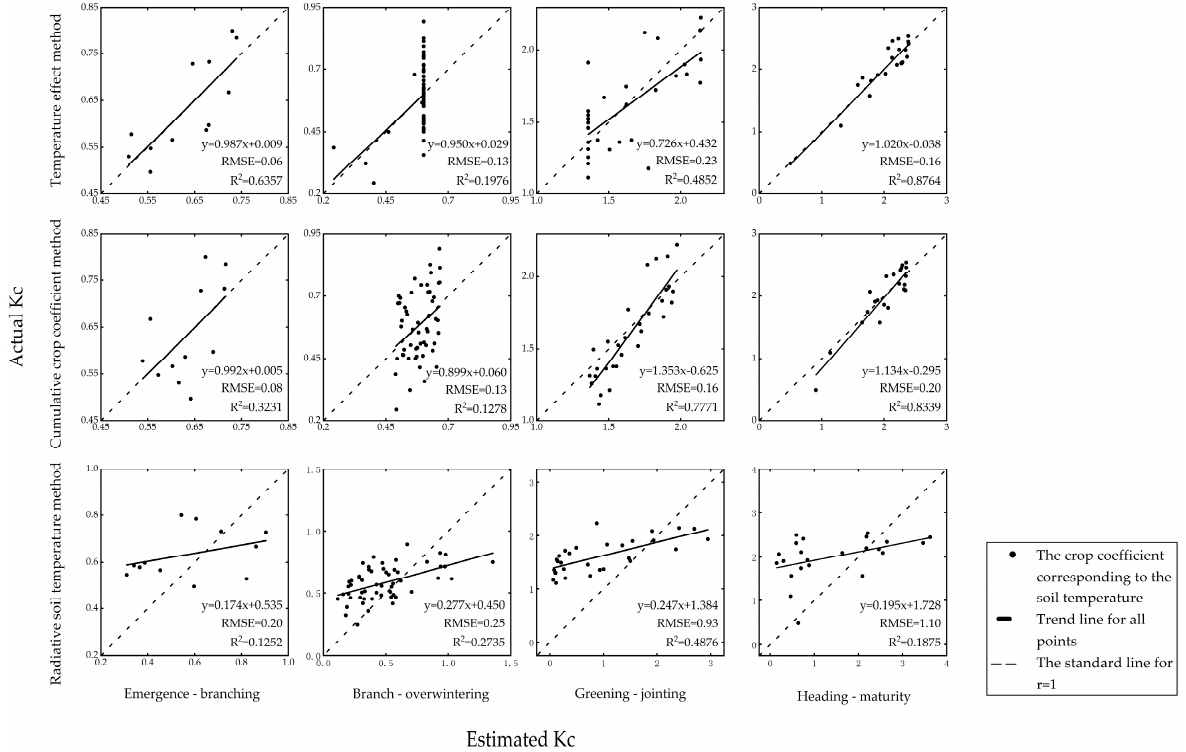
Figure 5. Results of three methods for estimating winter wheat crop coe ffi cients.